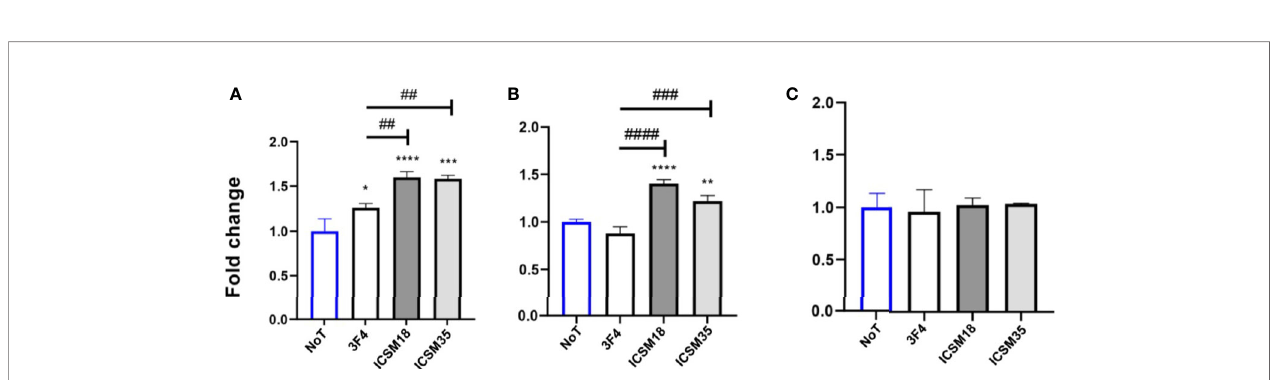
FIGURE 7 | Production of proin fl ammatory cytokines following direct microglial treatment (DMT) with anti-PrP antibody treatment of mouse primary neuron (MPN). Herein, fold change of NO (A) , IL-6 (B) and TNF- a (C) production in MPN following DMT. * p < 0.05, ** p < 0.01, *** p < 0.001, **** p < 0.0001 vs. no treatment (NoT). ## p < 0.01, ### p < 0.001, #### p < 0.0001 vs. 3F4 antibody treatment. P values were obtained by One-way ANNOVA followed by Tukey ’ s multiple comparisons test analysis by GraphPad Prism